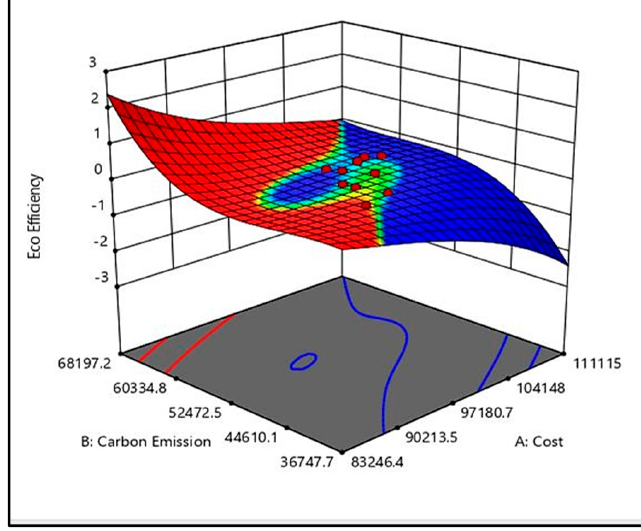
Figure 14. Response surface graph of blast furnace slag concrete used for double story houses.